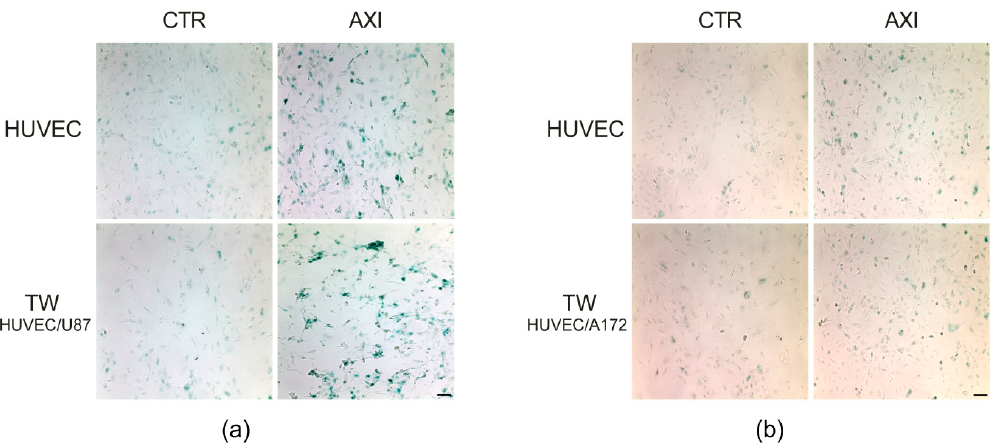
Figure 2. Axitinib-dependent SA- β - galactosidase staining of HUVECs wasnot altered by GBM cells coculture. Four days after Axitinib pulse, HUVECs appeared positive to β -galactosidase staining, with a typical blue color. This effect was not altered in HUVECs cocultured for 48 h in transwell with GBM cell lines, U87MG ( a ) or A172 ( b ). n = three biological replicates. Magnification 10×, scale bar 100 µm.